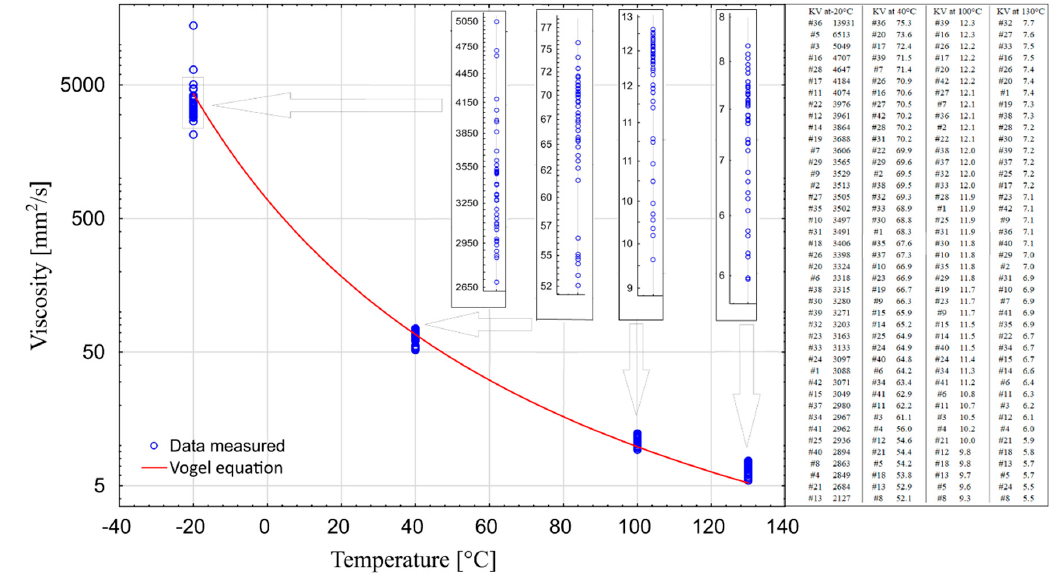
Figure 7. Viscosity curves in the temperature range from − 20 °C to 130 °C.